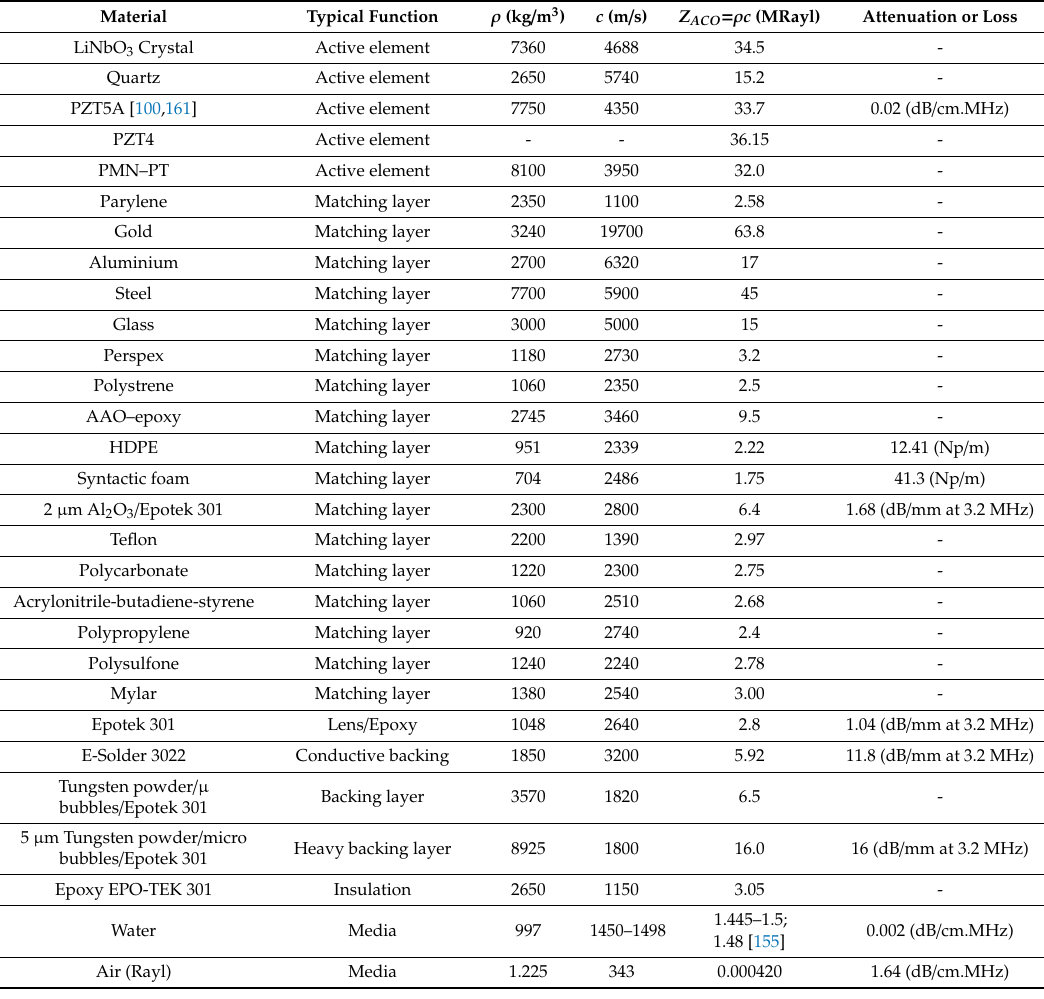
Table 4. Acoustic properties of typical piezoelectric transducer materials and media [154–160].